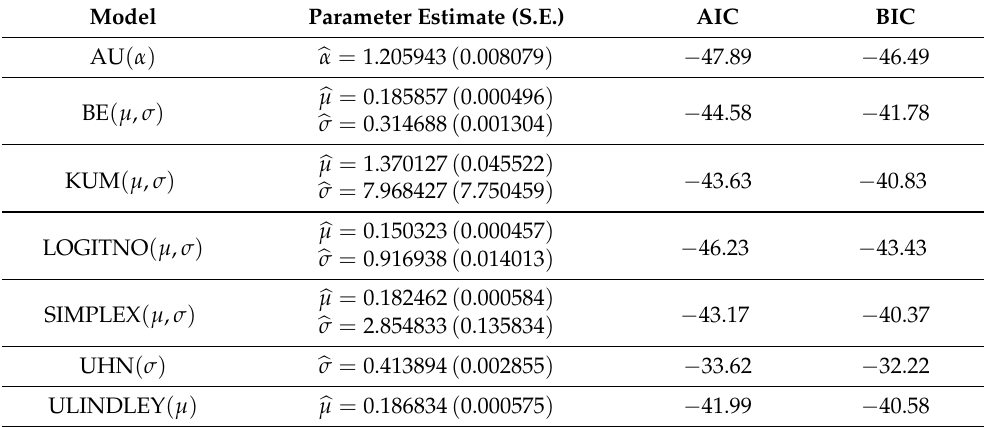
Table 2. Parameter estimates, AIC and BIC values (Chilean inflation data). S.E. = standard error. Model